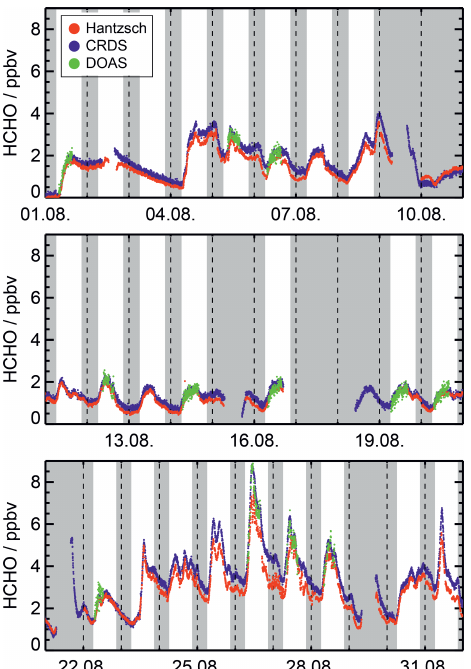
Figure 7. Formaldehyde measurements obtained by the Hantzsch, CRDS and DOAS instruments in experiments performed in the SAPHIR chamber during August 2019, when the chamber was con- tinuously flushed with ambient air (JULIAC campaign). Grey ar- eas indicate nighttime or periods when the chamber roof was kept closed during the daytime, and dashed vertical lines indicate mid-